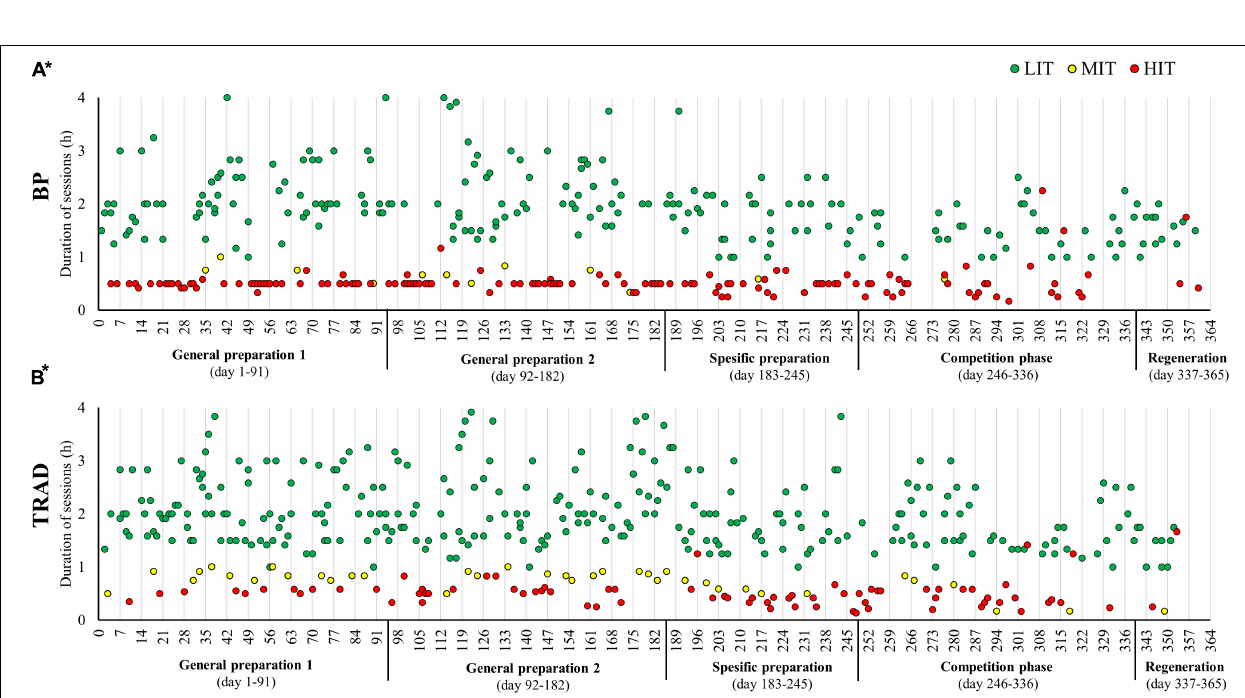
FIGURE 3 | The duration of low (LIT), moderate (MIT), and high-intensity (HIT) sessions performed across the annual cycle using block periodization of HIT (BP) (A) , and the season using traditional periodization (TRAD) (B) . ∗ LIT sessions with a duration < 1 h is not included in the figures.